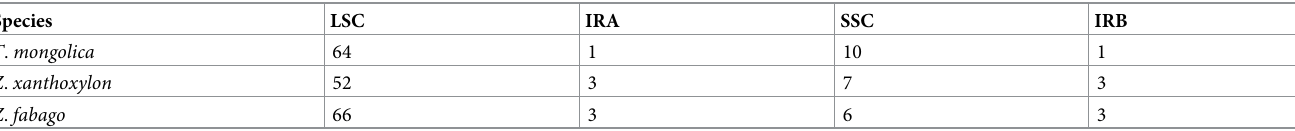
Table 5. The summary of SSRs distribution in different regions of three chloroplast